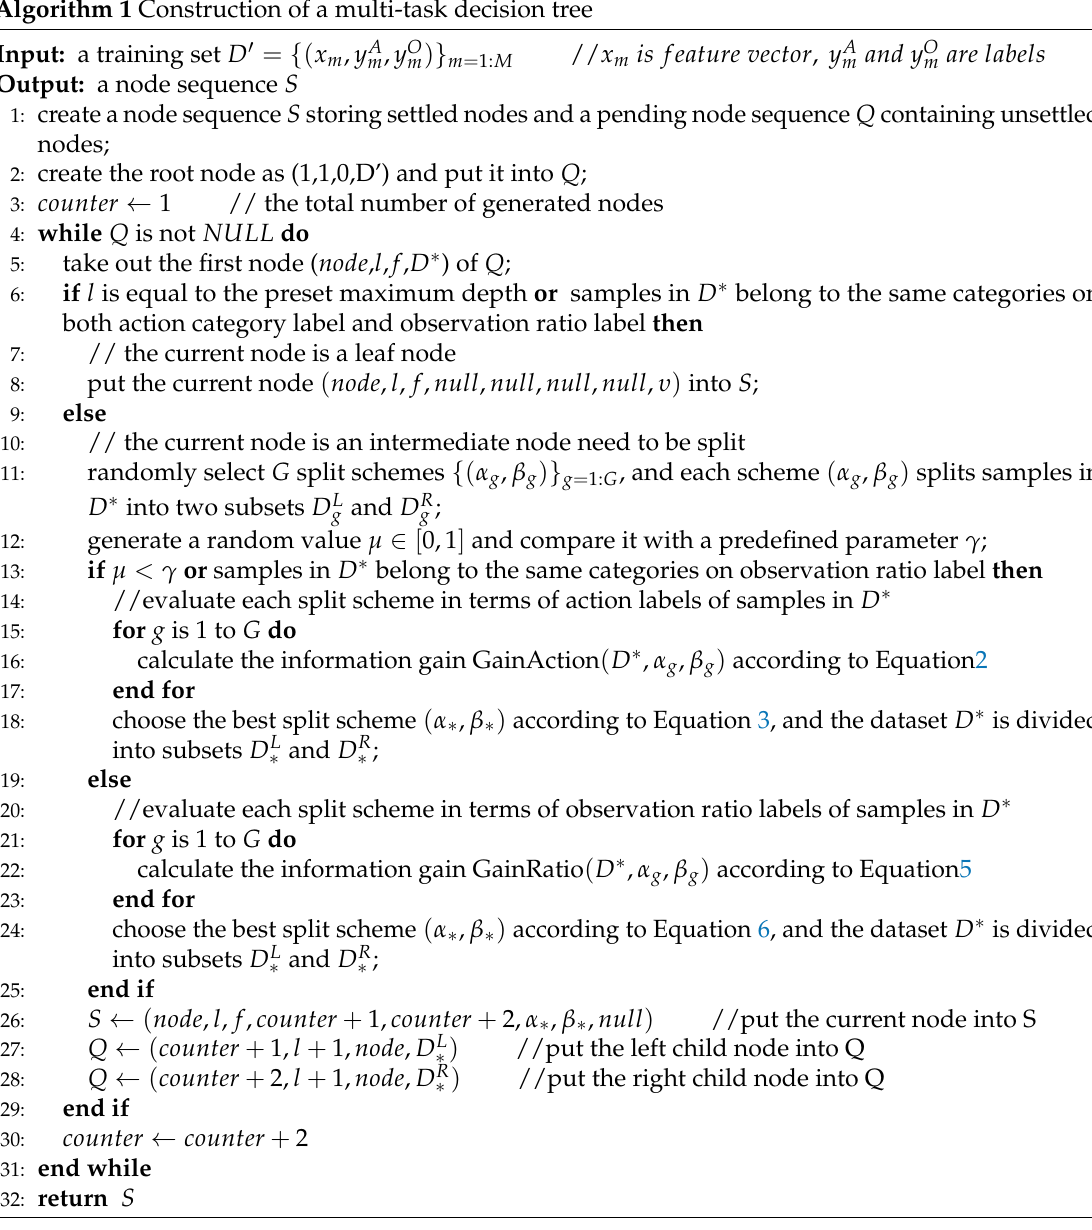
Algorithm 1 Construction of a multi-task decision